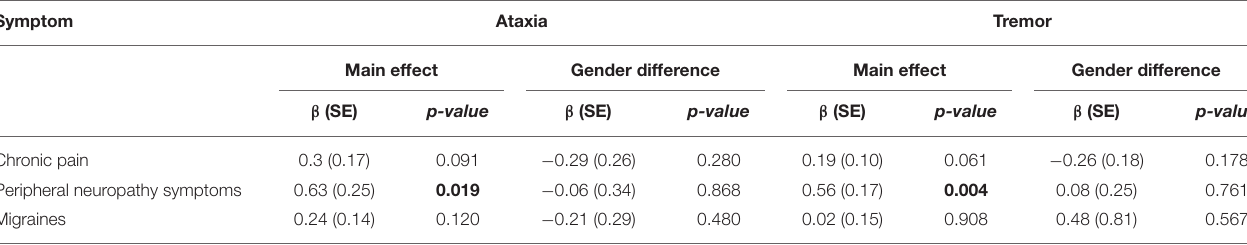
TABLE 2 | Associations between age onset of symptoms and age onset of ataxia and